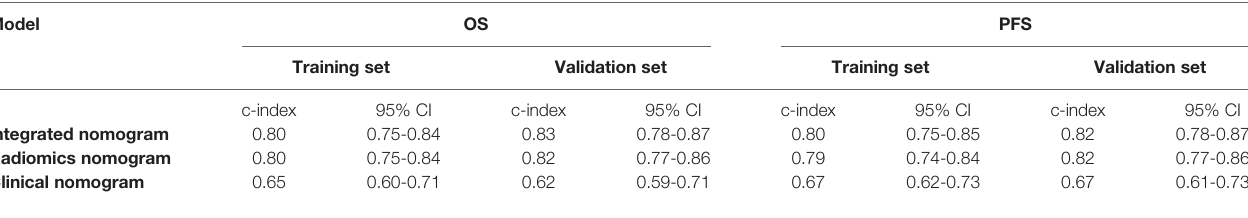
TABLE 5 | Prognostic nomogram